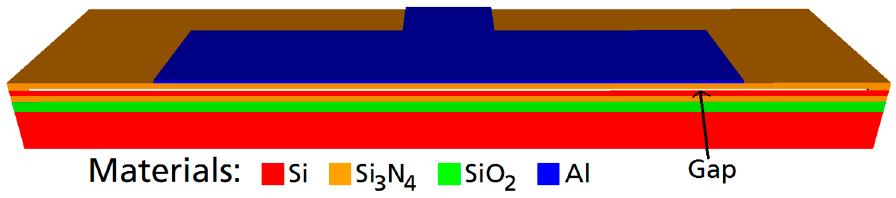
Table 1. Material parameters used in the simulation.